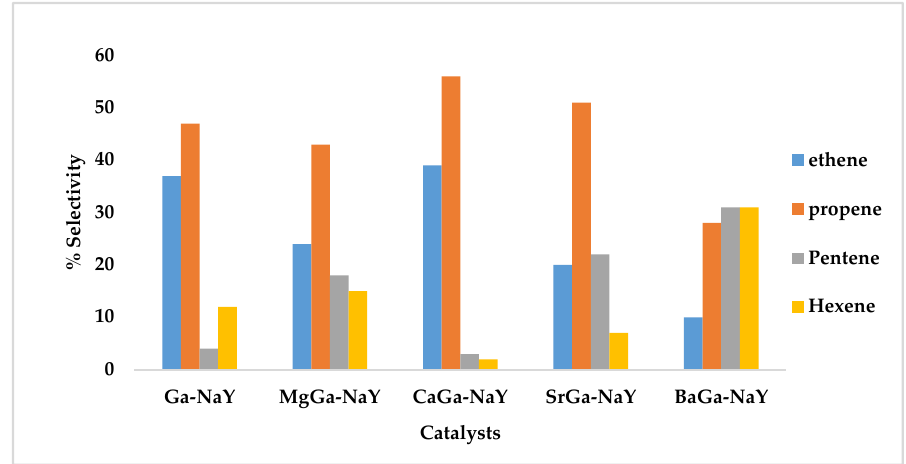
Figure 8. Selectivity towards different cracked products, at iso ‐ conversion (6 ± 1%) of n ‐ octane at a fixed temperature of 450 °C.